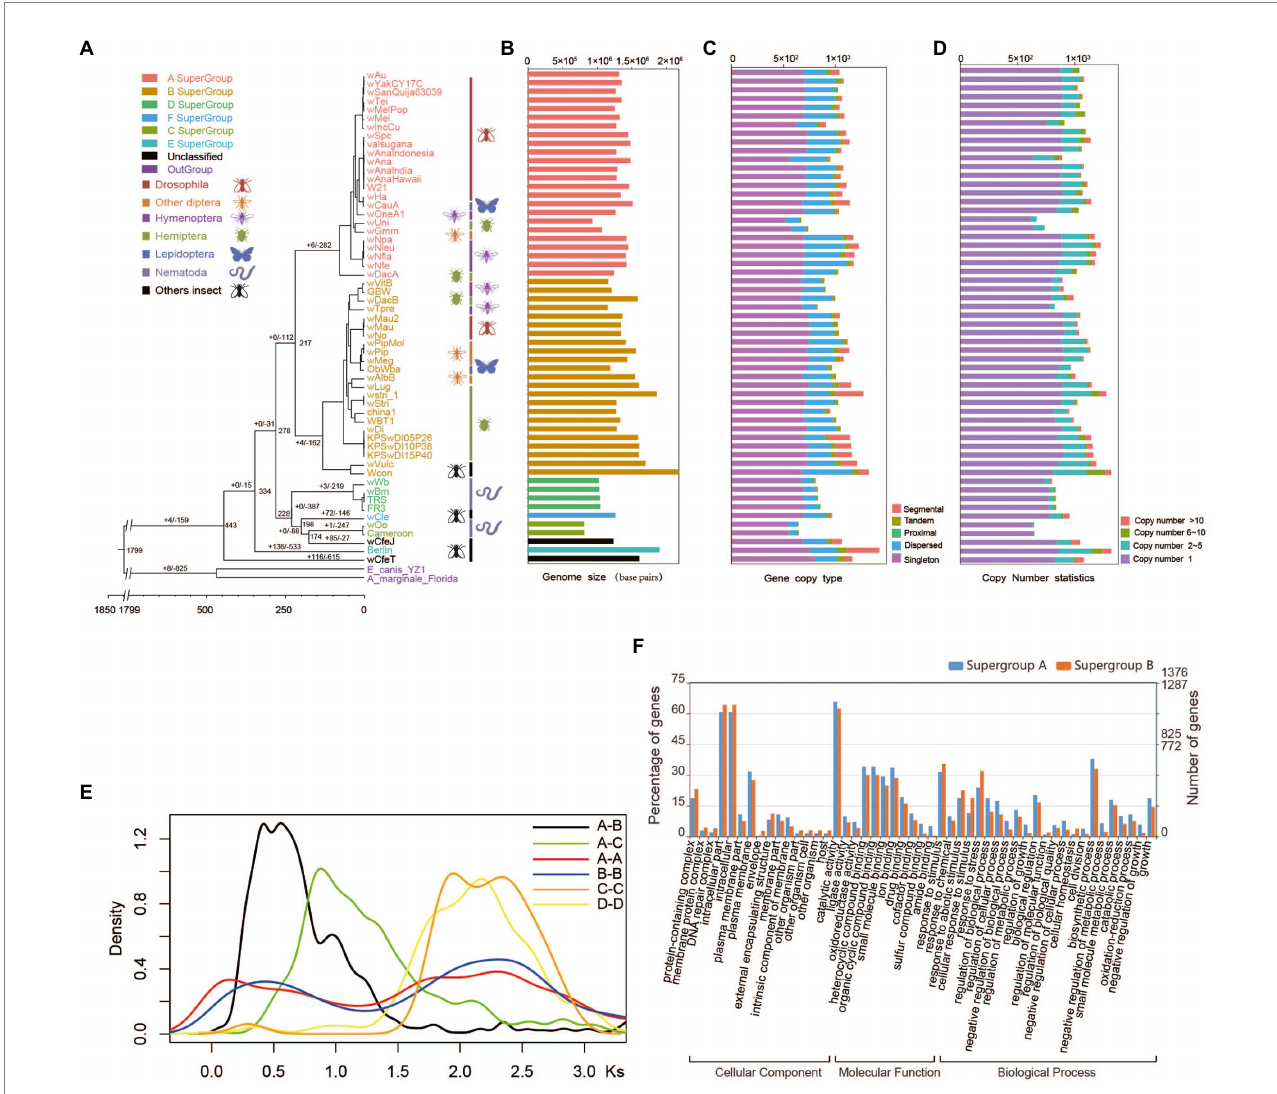
FIGURE 1 Evolution of Wolbachia genomes. (A) Paleohistory of Wolbachia with Ehrlichia canis and Anaplasma marginale as outgroups. The number at the nodes represents the divergence time of species. (B) Genome sizes of Wolbachia strains. (C) The different gene copy types in Wolbachia strains were identified and classified by using the software duplicate_gene_classififier. The gene duplication types were classified as segmental, tandem, proximal and dispersed duplications. Segmental indicates anchor/collinear genes in syntenic blocks; tandem indicates continuous repeat; proximal indicates in nearby chromosomal region but not adjacent; dispersed indicates other modes than segmental, tandem and proximal. (D) Numbers of gene copies. (E) Ks distribution of syntenic orthologues from four Wolbachia supergroups. The y-axis shows the ratio of gene pairs in the syntenic block. (F) Functional enrichment of all duplicated genes in supergroups A and B according to Gene Ontology (GO)